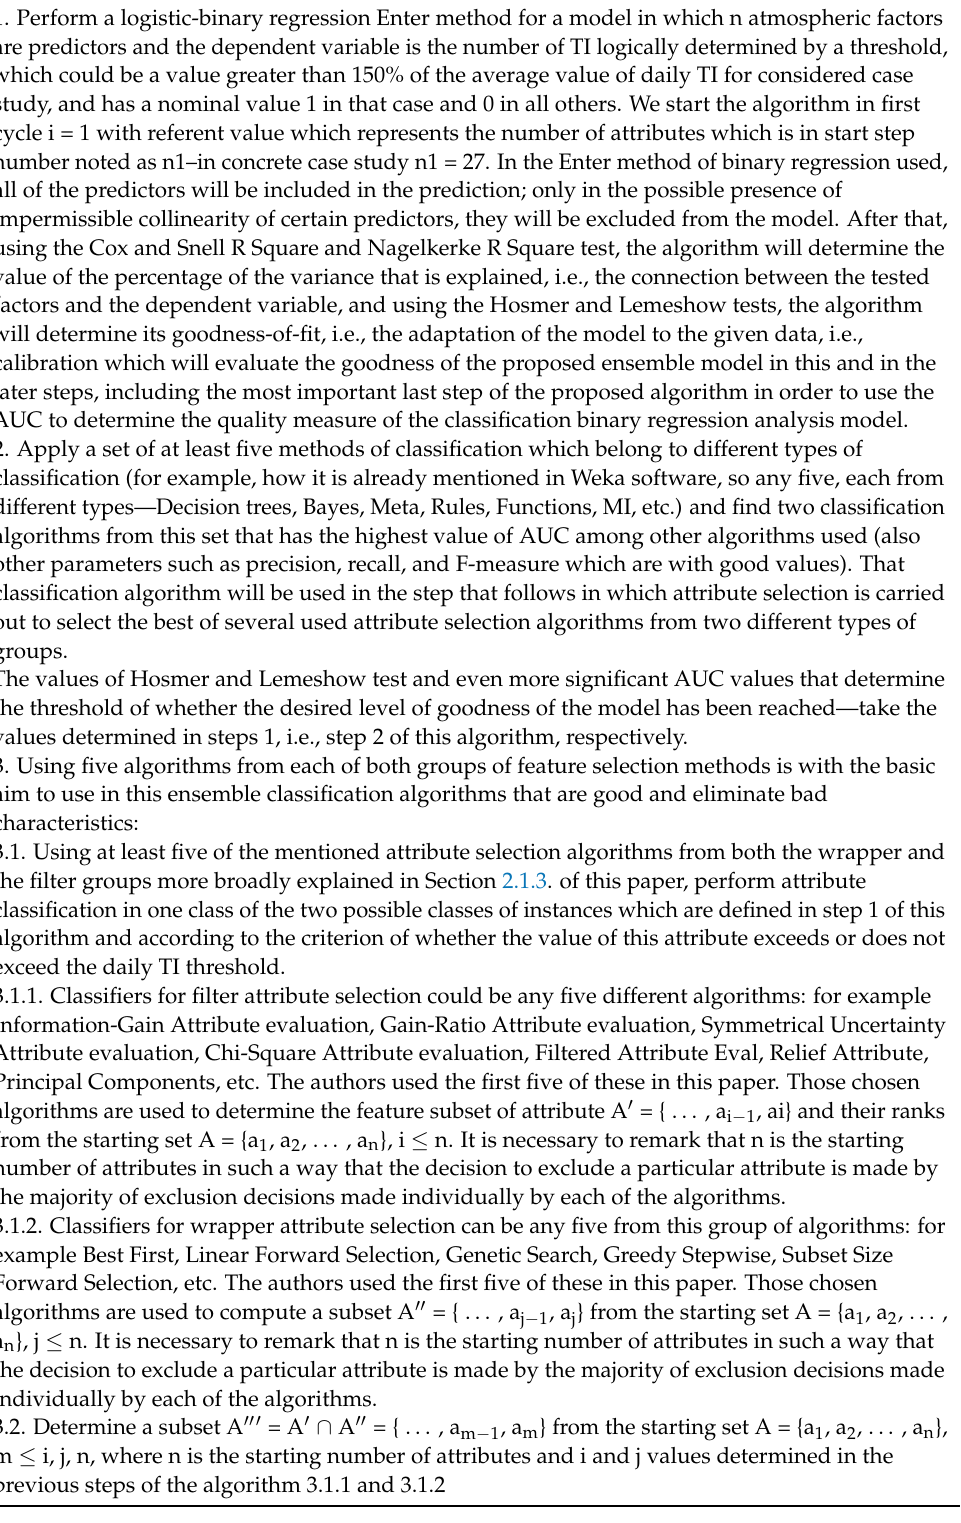
Algorithm 1 : Obtaining significant predictors of TI caused by atmospheric